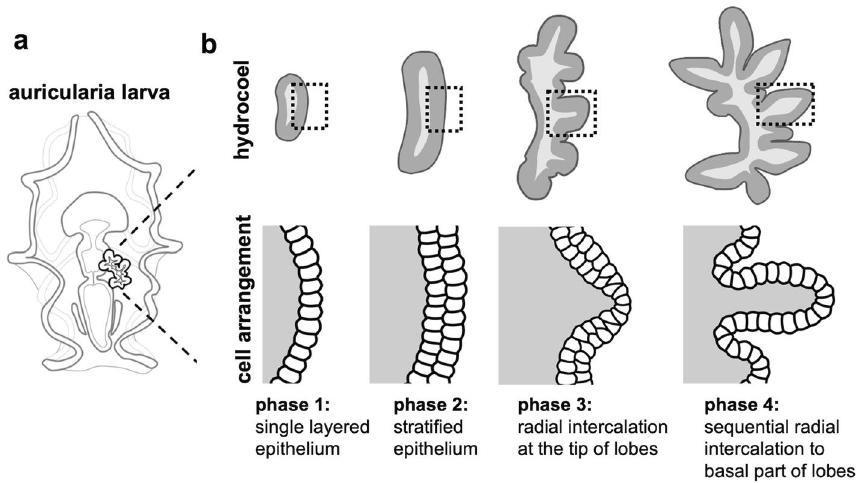
Figure 6. Schematic illustration of the change in cell arrangement during the hydrocoel lobe morphogenesis. ( a ) represents an auricularia larva and ( b ) represents the development of its hydrocoel. The upper panel shows the overall shape of the hydrocoel, and the cell arrangement of the hydrocoel epithelium in dotted areas is shown in the lower panel. The hydrocoel at phase 1 consists of a single cell sheet, and it seemed to be multilayered at phase 2. As the formation of the hydrocoel lobe proceeded, the cell sheet became single layered again sequentially from the tip of the hydrocoel lobe (phase 3) to the proximal part of the lobe (phase 4).